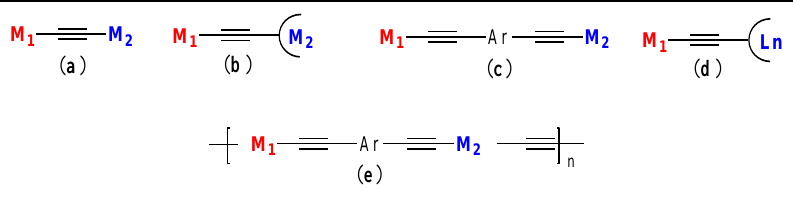
Figure 1. General chemical structure of some of the d-d and d - f fragments containing heterometallic complexes. M 1 and M 2 = transition metal ions ( a ), Ln = a lanthanide core ( b ), Ar = conjugated carbocyclic/heterocyclic spacers and ( c ) semi-circle = bi- ( d ) or polydentate donor ligands ( e